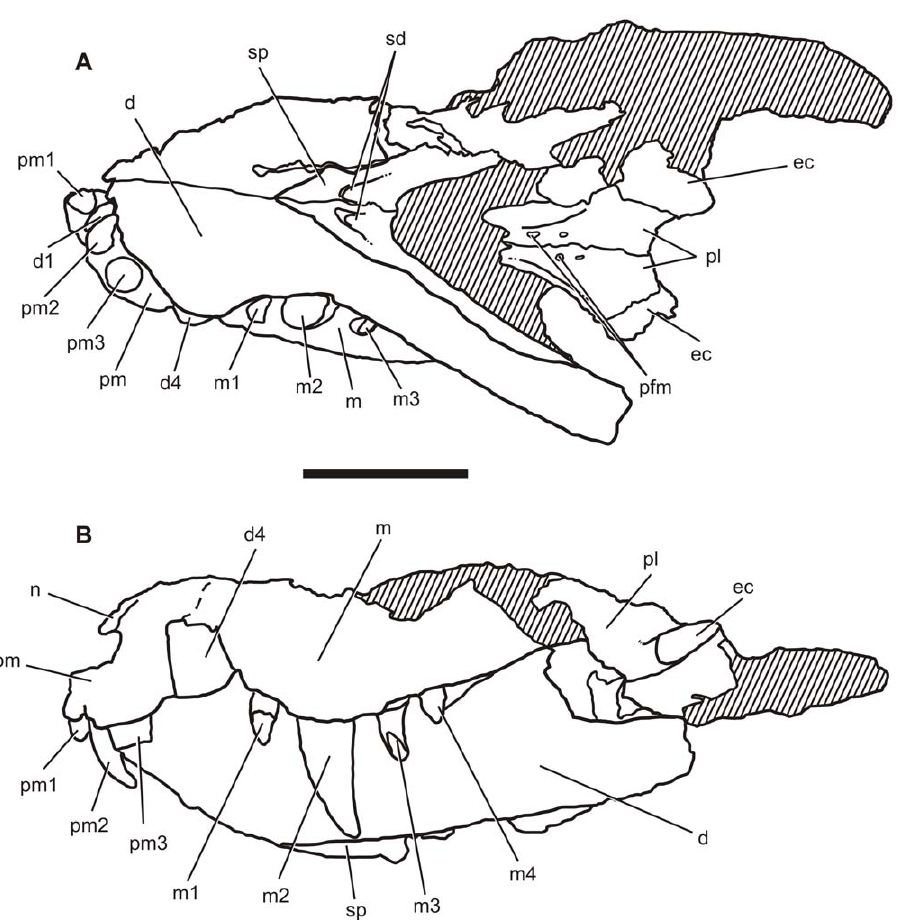
Figure 7. Drawing of the skull of the referred specimen of Pissarrachampsasera (LPRP/USP 0018). A) ventral; B) lateral (mirrored). Dashed line represents possible premaxilla-maxilla suture. Hatched areas indicate broken surfaces and matrix. Abbreviations: d, dentary; d1, dentary tooth 1; d4, dentary tooth 4; premaxilla; pm1-pm3, premaxillary teeth 1–3; sd, splenial depressions; sp, splenial. Scale bar equals 5 cm.